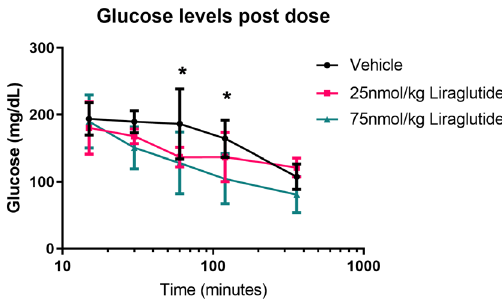
Figure 2. 75 nmol/kg liraglutide reduces blood glucose levels in SOD1 G93A mice. Blood glucose levels measured on an optium geo glucose meter at multiple time points post dose with vehicle, 25 and 75 nmol/kg liraglutide (mean ± SD). There is a significant decrease in glucose levels at 60 ( P = 0.0285) and 120 ( P = 0.0236) minutes post dose in the 75 nmol/kg liraglutide group compared to vehicle (n = 4 per group, two-way